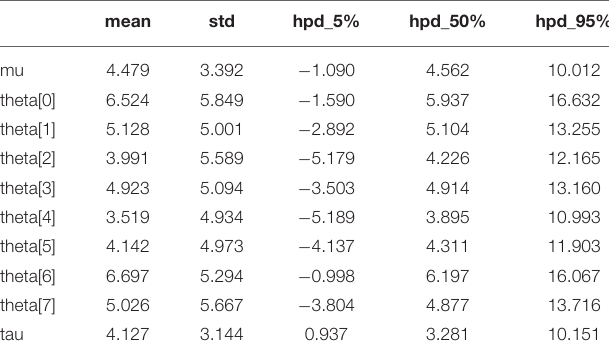
TABLE 1 | Posterior statistics in a tabular format for the centered hierarchical model of the eight schools problem. mean std hpd_5%